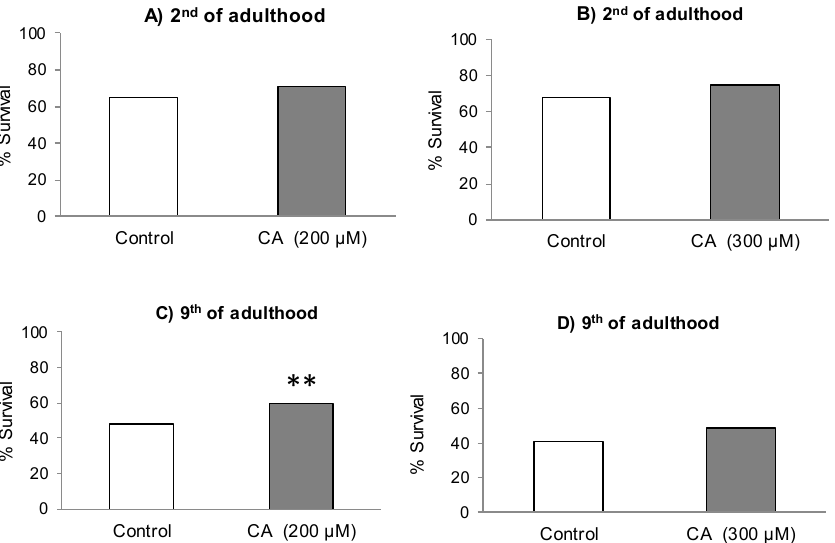
Figure 2. Survival percentages of C. elegans subjected to thermal stress (35 ◦ C, 8 h) on the second and ninth day of adult, grown in the absence (controls) or presence of 200 µ M of CA ( A , C ) or 300 µ M of CA ( B , D ). The number of worms used in each assay was 300. The statistical significance was calculated using the Chi Square test (** p < 0.01 and *** p < 0.001).